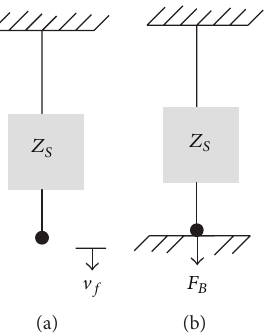
Figure 1: Free velocity and blocked force.